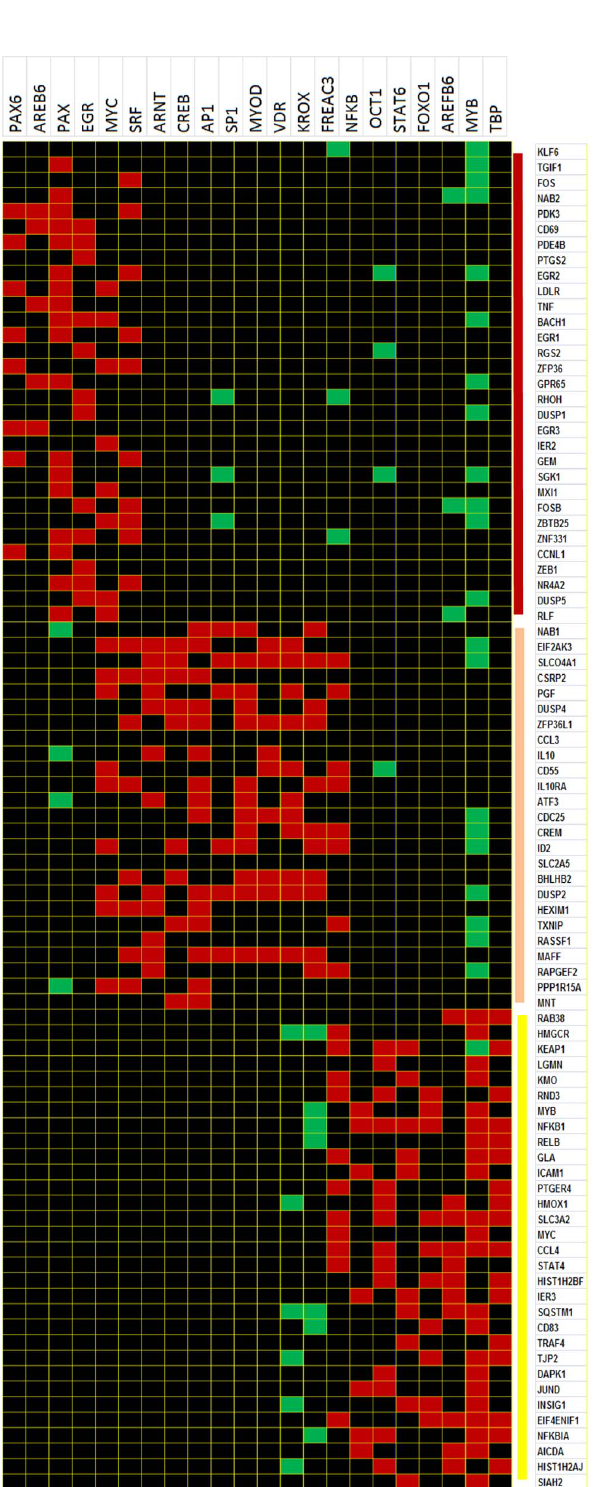
Figure 4. Transcription factor analysis of the variable gene clusters. Transcription factors tested are presented at the top of the diagram. The cluster content is shown along the right. Individual elements of the matrix are colored by the significance of the p-values (threshold p=0.05): over-representation in the matrix is indicated in red, under-representation is indicated in